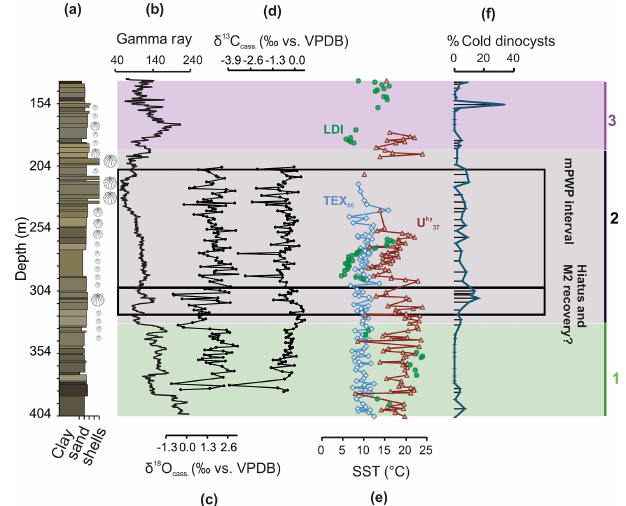
Figure 2. Marine proxies for the Hank borehole. (a) The depth and lithology of the Hank sediments, with shell material qualitatively indicated by shell symbols. (b) The smoothed gamma ray (GR) log (https://www.dinoloket.nl, last access: 15 April 2019). (c) Sta- ble oxygen and (d) stable carbon isotope records for the endoben- thic Cassidulina laevigata . (e) SST records based on TEX 86 (blue (cid:48) diamonds), U K (red triangles), and LDI (green squares). (f) Per- 37 cent cold taxa of dinoflagellate cysts. Intervals 1, 2, and 3 dis- cussed in the text are indicated by green (early Pliocene), grey (mid- Pliocene), and purple (late Pliocene–early Pleistocene). The tuned interval and the position of the hiatus marking the M2 glacial event are represented by a black